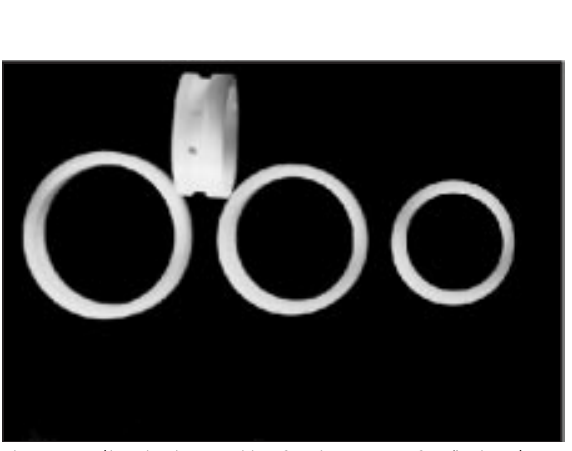
Fig. 1 - Anéis sulcados e multiperfurados para confecção de prótese intraluminal.